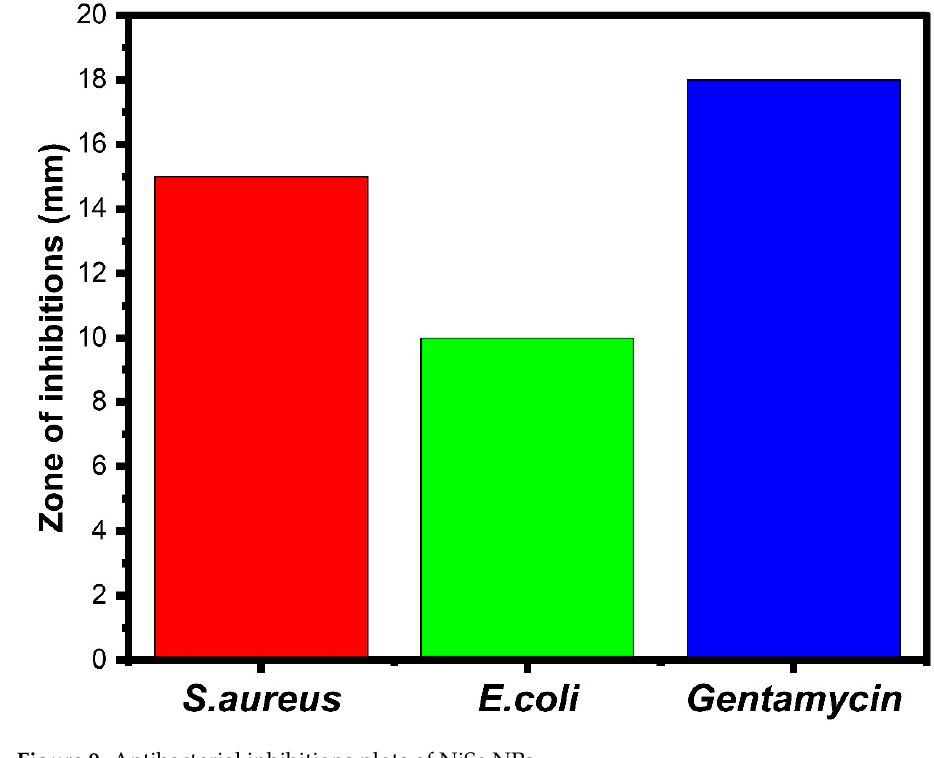
Figure 9. Antibacterial inhibitions plots of NiSe NPs.